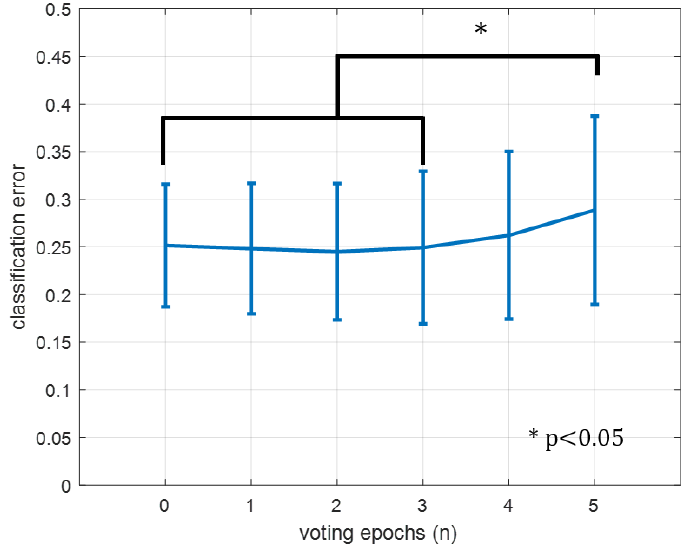
Figure 7. Effect of varying voting epochs on classification error. Zero epochs is equivalent to not voting and just accepting each epoch’s classification. Error bars are the standard deviation of the mean. * denotes significance at p <